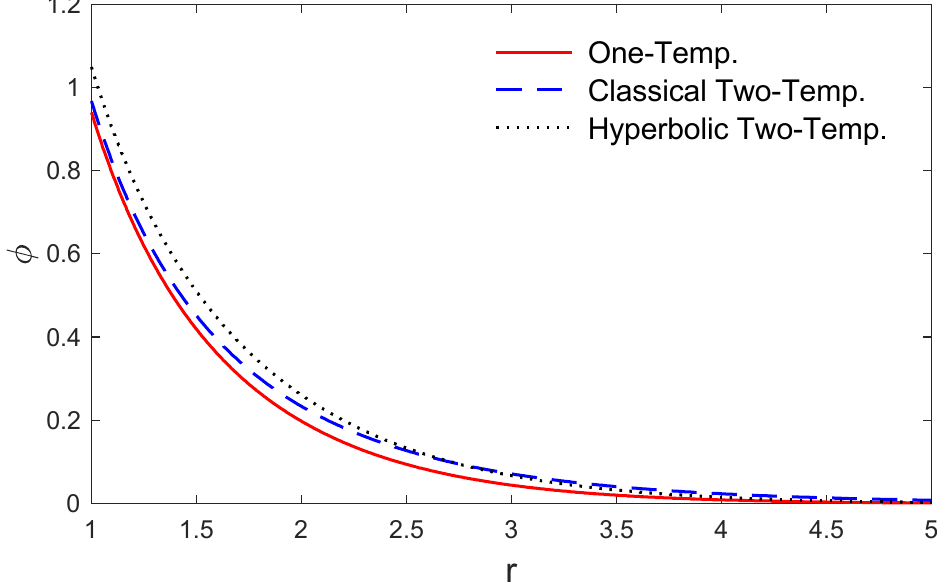
Figure 1. The variation of conductive temperature with distance for different models. Mathematics 2020 , 8 , x